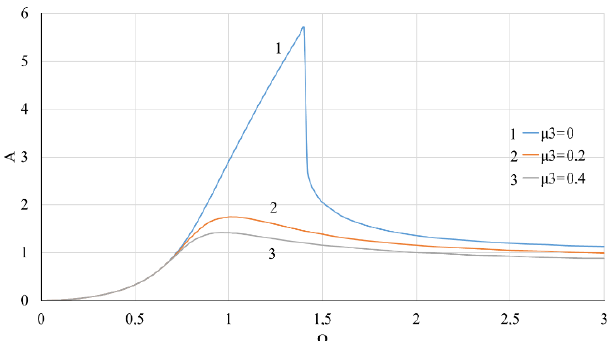
Figure 10. Dependence of the vibration amplitude A on the rotor velocity (cid:127) with nonlinear stiffness coefficient of the support K 3 = 0 . 05 and at value of the coefficient of linear viscous damping µ 1 = 0 . 1 and various values of nonlinear viscous damping coefficient µ 3